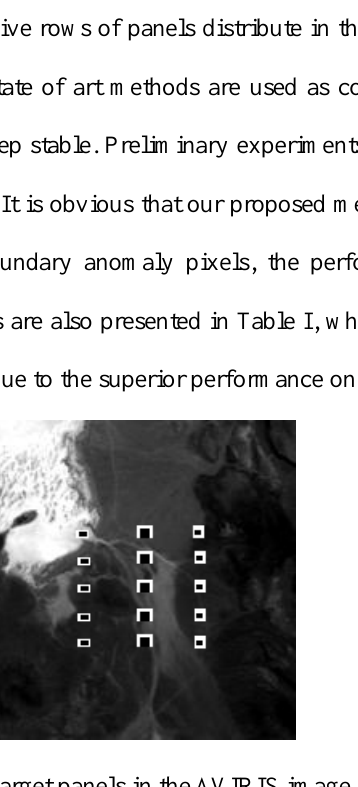
Fig. 2. Target panels in the AVIRIS image. Fig. 3. Performances of different methods.